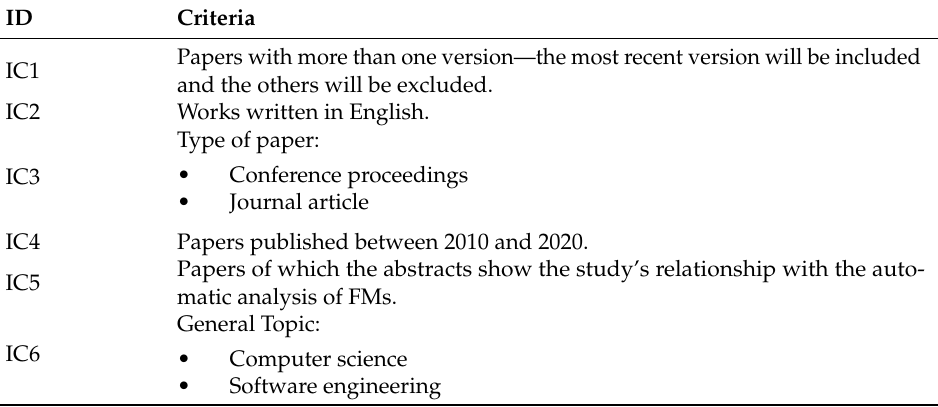
Table 8. Inclusion criteria definition.